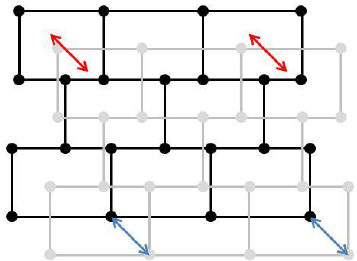
Figure 4. Two sets of polygonal data to be conflated: two feature-to-feature matchings (red arrows) and two vertex-to-vertex matchings (blue